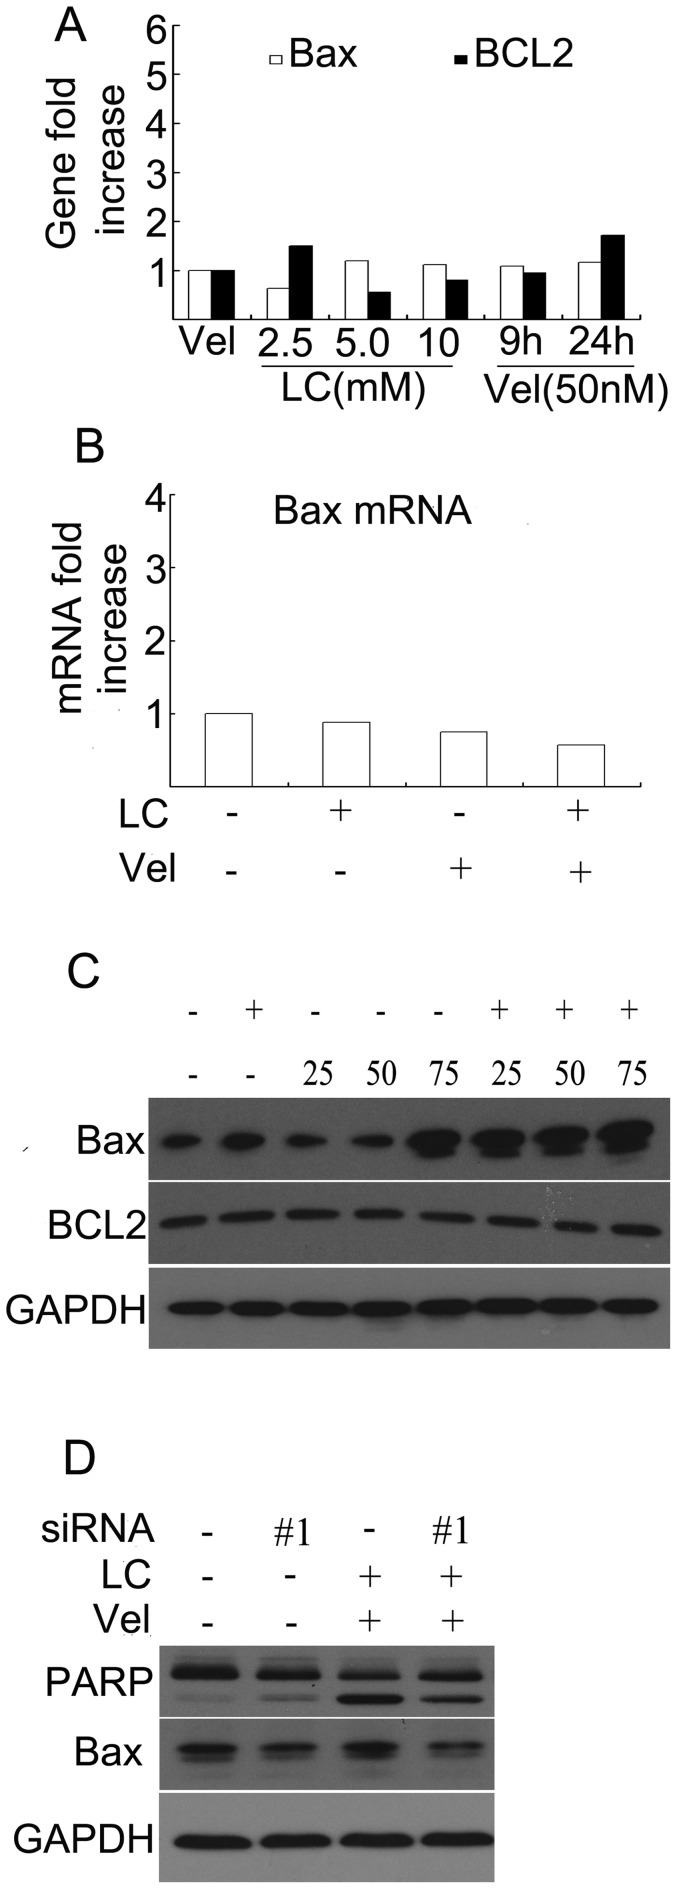
Vel and LC synergistically induces Bax accumulation and silencing Bax by siRNA reversed PARP cleavage.(A) As treated and analyzed in Figure 2A, Bax and Bcl-2 gene expression was shown. (B) As treated and analyzed in Figure 2B, Bax mRNA was detected by real-time PCR and fold increase of Bax mRNA was shown. (C) As treated in Figure 4A, Bax and Bcl-2 protein levels were detected. Representative images were shown. (D) HepG2 cells were transfected with Bax-siRNA (#1) for 48 h and then treated with the combination of LC (5 mM) and Vel (50 nM) for 24 h, Western blot was performed to detect Bax and PARP cleavage. GAPDH was used as a loading control.